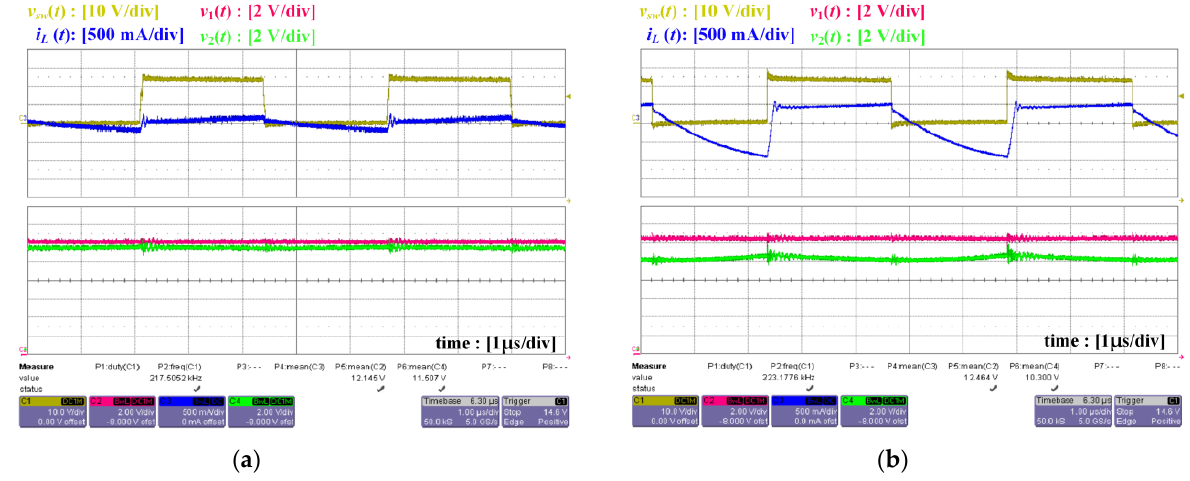
Figure 9. Experimental waveform of fly-buck converter: ( a ) C 1 = 10 μ F and P 2 = 1 W; ( b ) C 1 = 10 μ F and P 2 = 5 W.